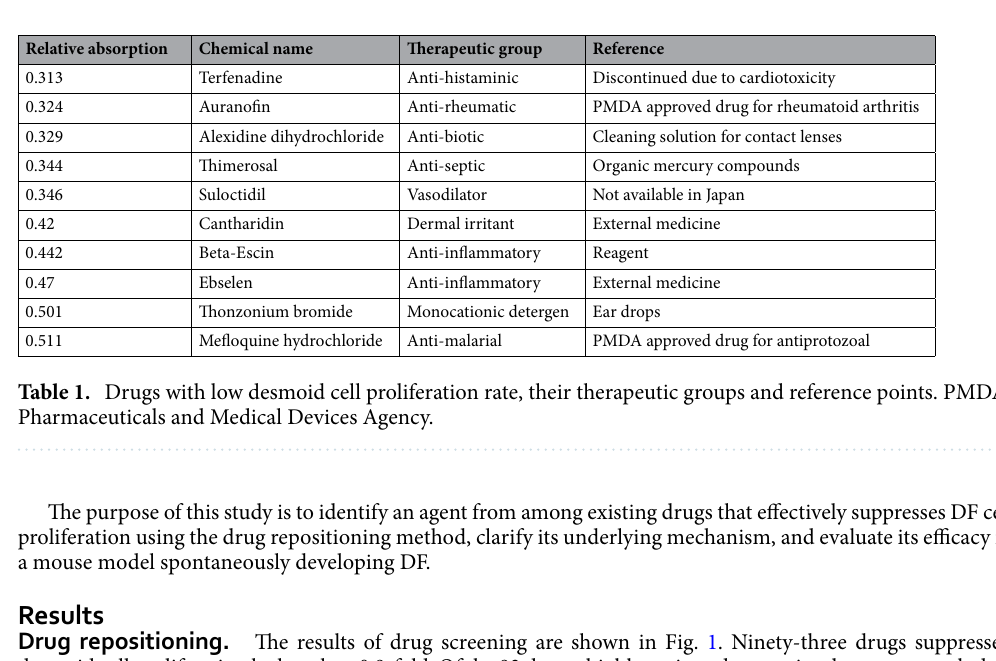
Relative absorption Chemical